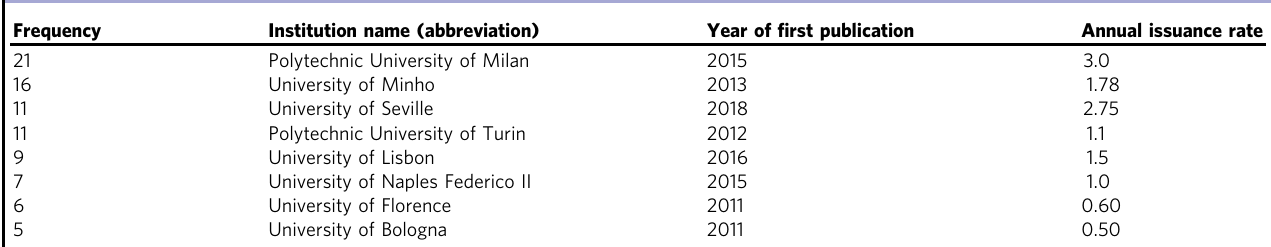
Table 4 Institutional distribution of HBIM research.